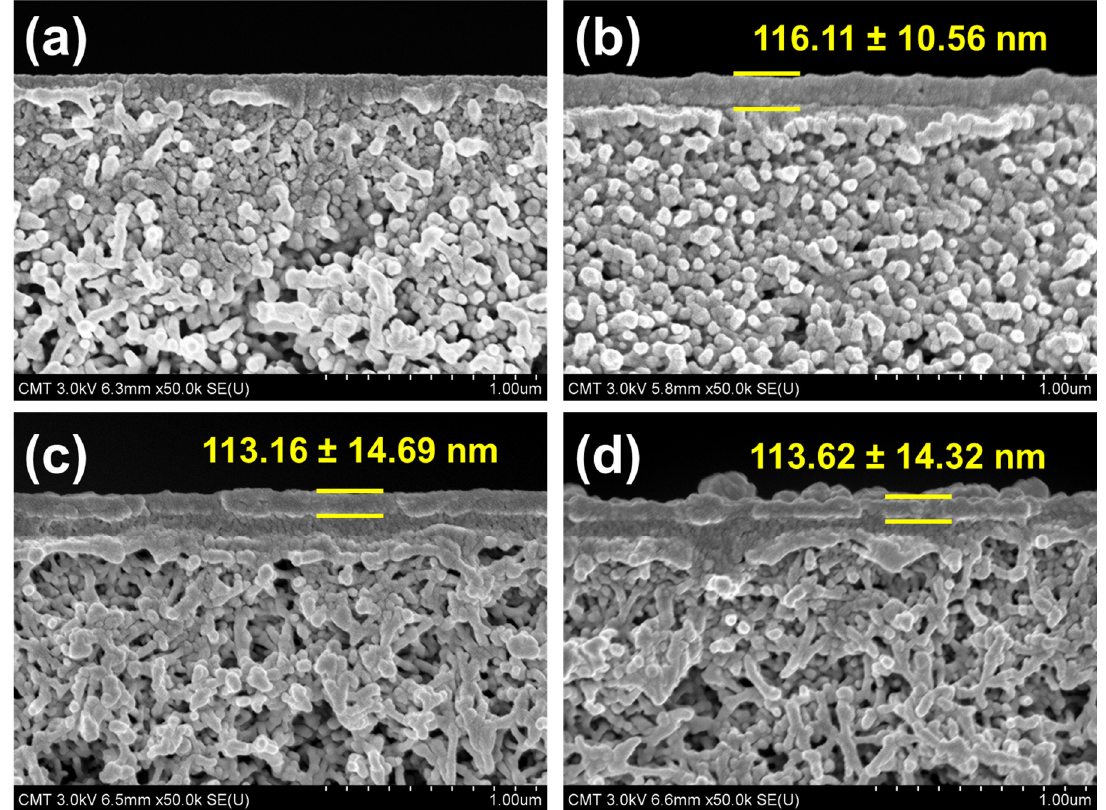
Figure 8. Cross-sectional FESEM images of ( a ) PSf, ( b ) TFC, ( c ) TFN Na-MMT and ( d ) TFN O-MMT . Particle concentration = 0.05 g O-MMT/g TMC.